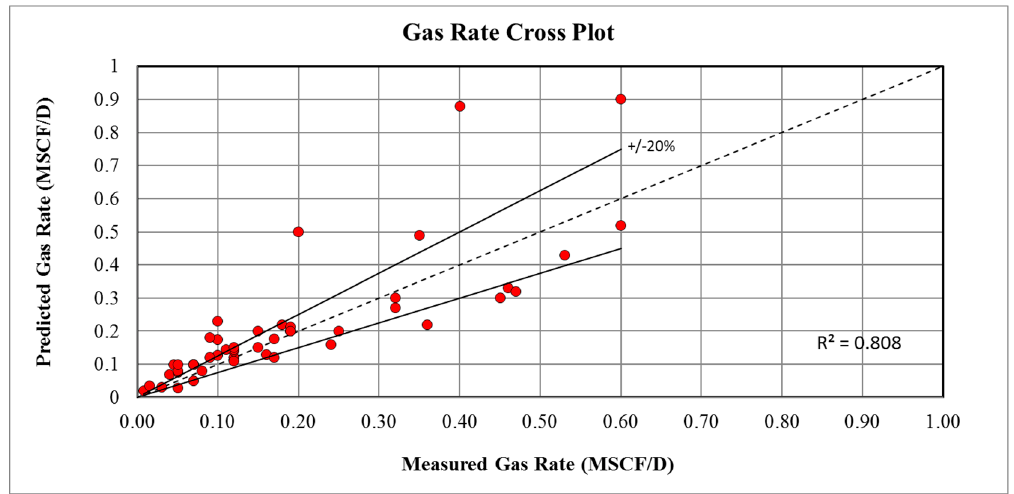
Figure 16. Predicted vs measured gas rate using the Colebrook correlation.